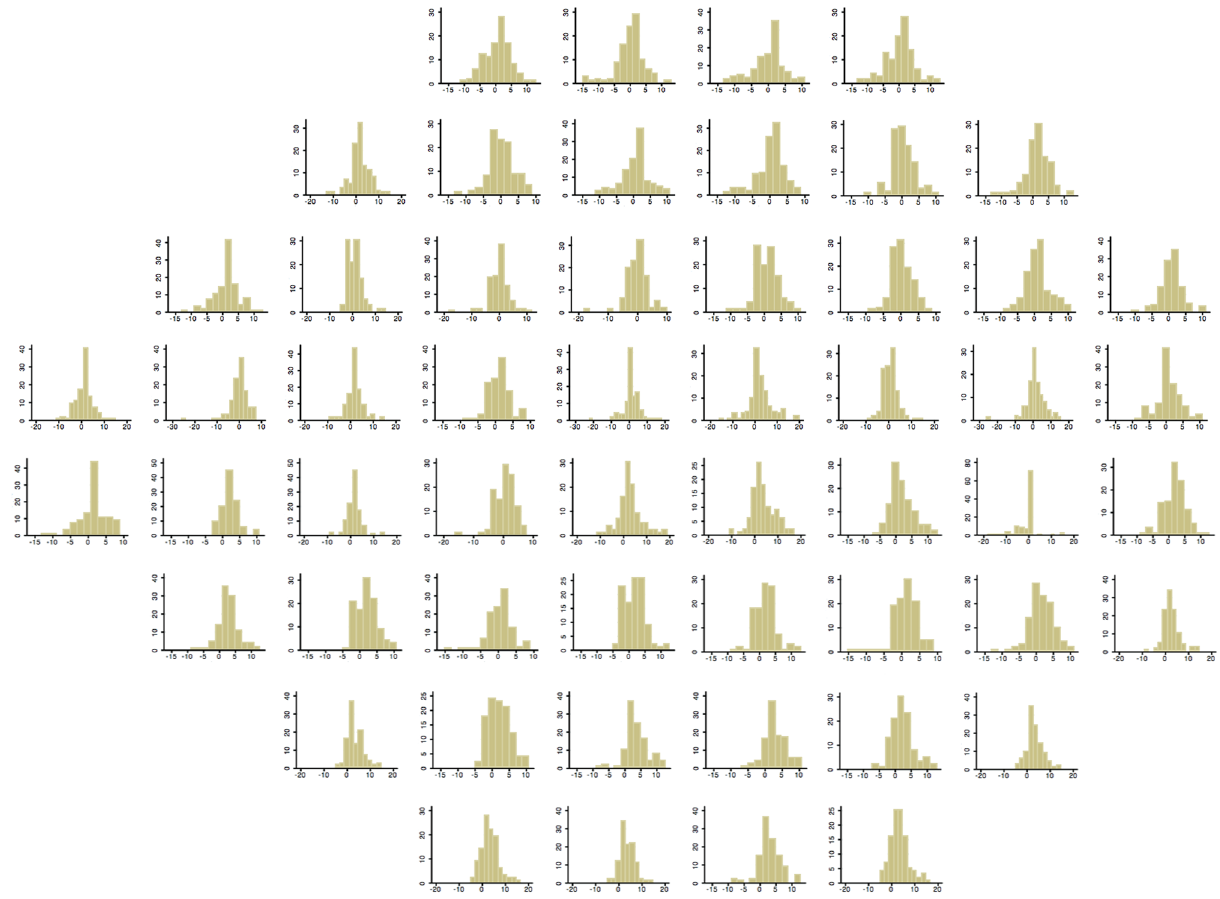
Figure 5. Histograms showing the distribution of point by point differences in sensitivity (in decibels) between standard automated perimetry (SAP) and saccadic vector optokinetic perimetry (SVOP) for all participants and for all test locations. The difference in sensitivity between SVOP and SAP is shown on the x-axis and the frequency of differences on the